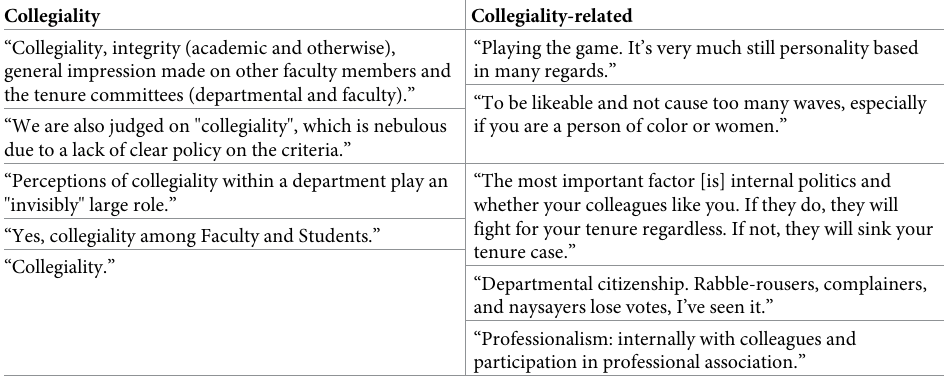
Table 4. A selection of open-ended survey responses coded as either collegiality or collegiality-related . Collegiality